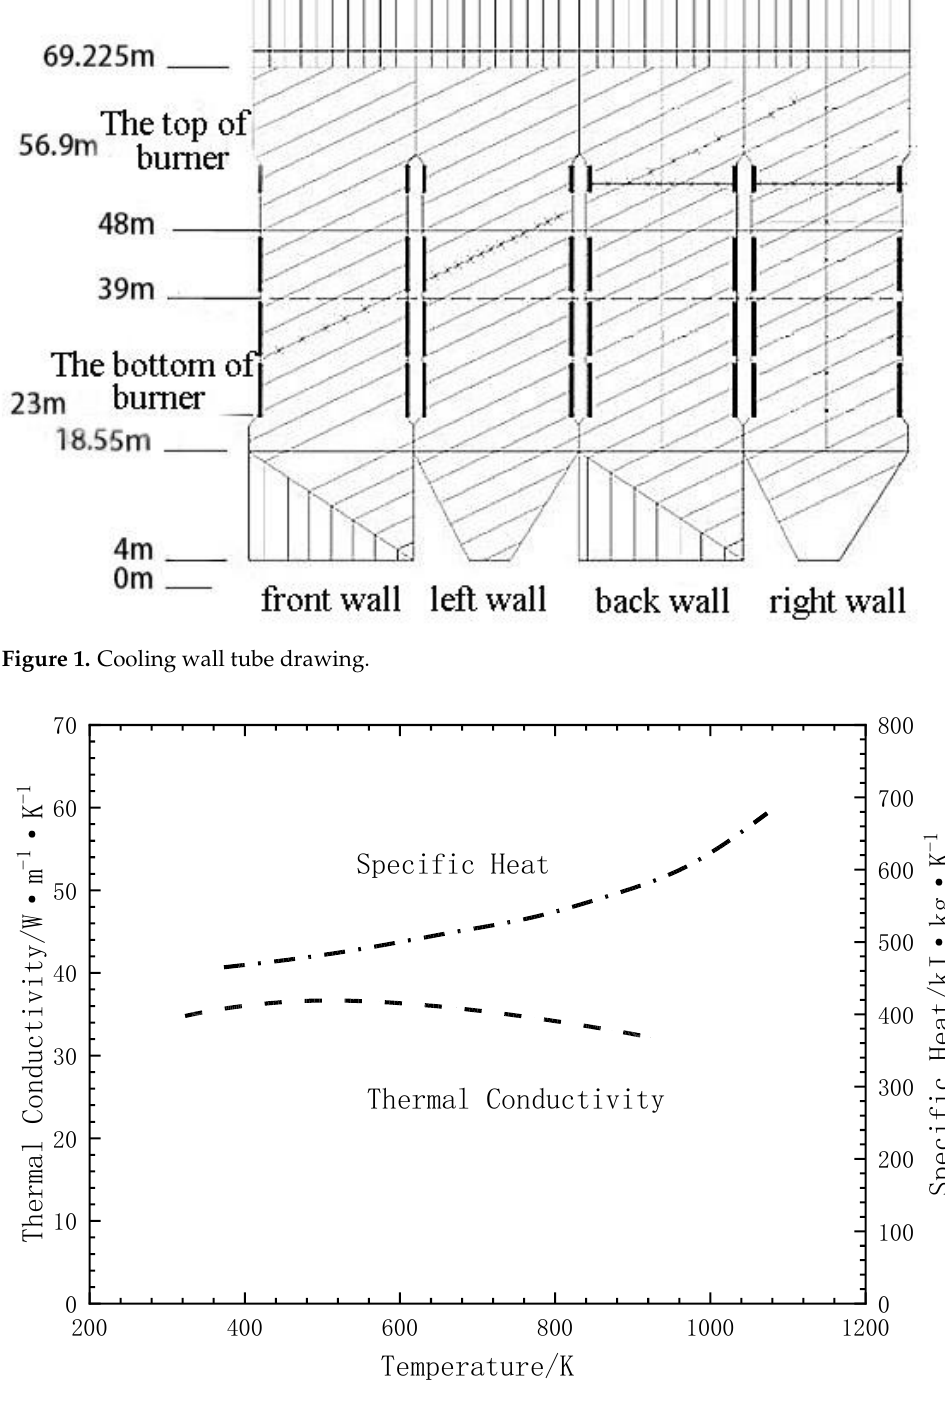
Figure 2. Physical properties of SA-213T23.